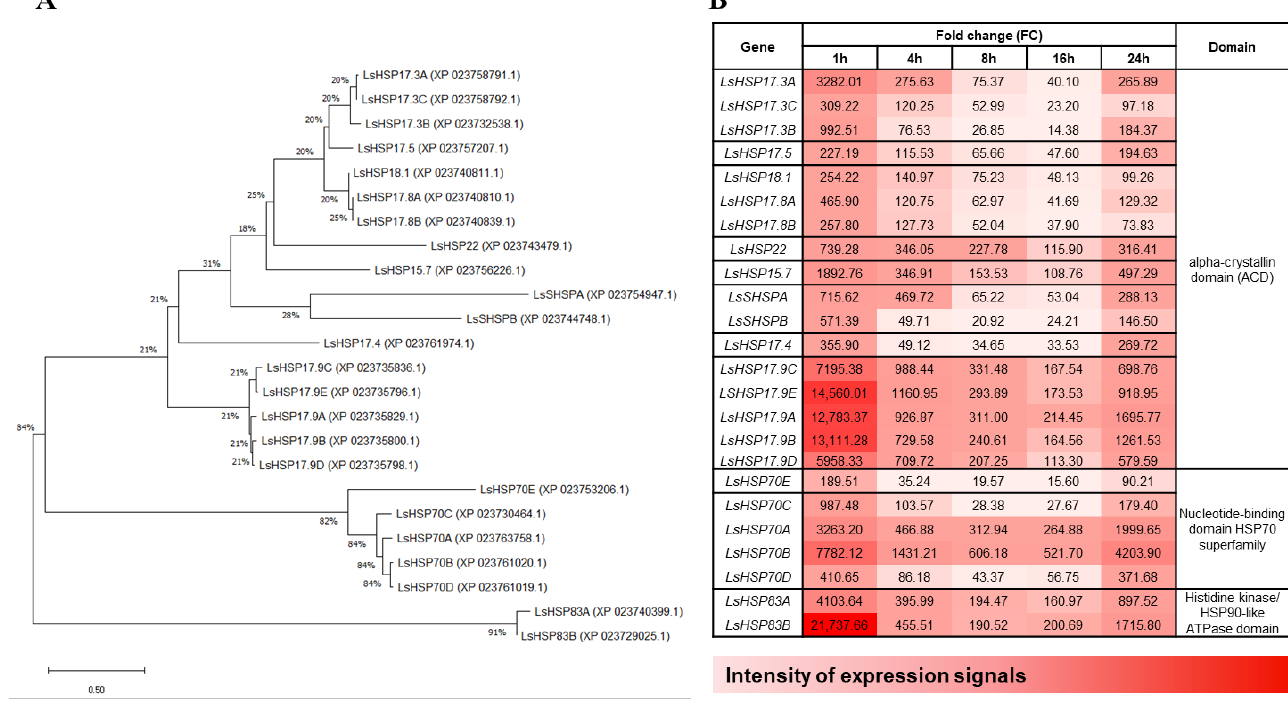
Figure 5. Phylogenetic tree based on protein sequences of heat shock proteins (HSP). Phylogenetic analysis of the LsHSPs whose mRNA expression is upregulated under heat stress in lettuce. ( A ) The neighbor-joining phylogenetic tree was constructed using MEGA X and tested by 1000 bootstraps. Those proteins can be grouped by their main domain: (1) the upper cluster contained the alpha-crystallin domain, (2) the middle cluster contained the nucleotide-binding domain (NBD) of the HSP70 superfamily, and (3) the last cluster contained the α-crystallin domain (ACD). ( B ) The expression level pattern of LsHSP genes under heat stress are visualized in a heat map. The darker red represents the high intensity of expression signals.